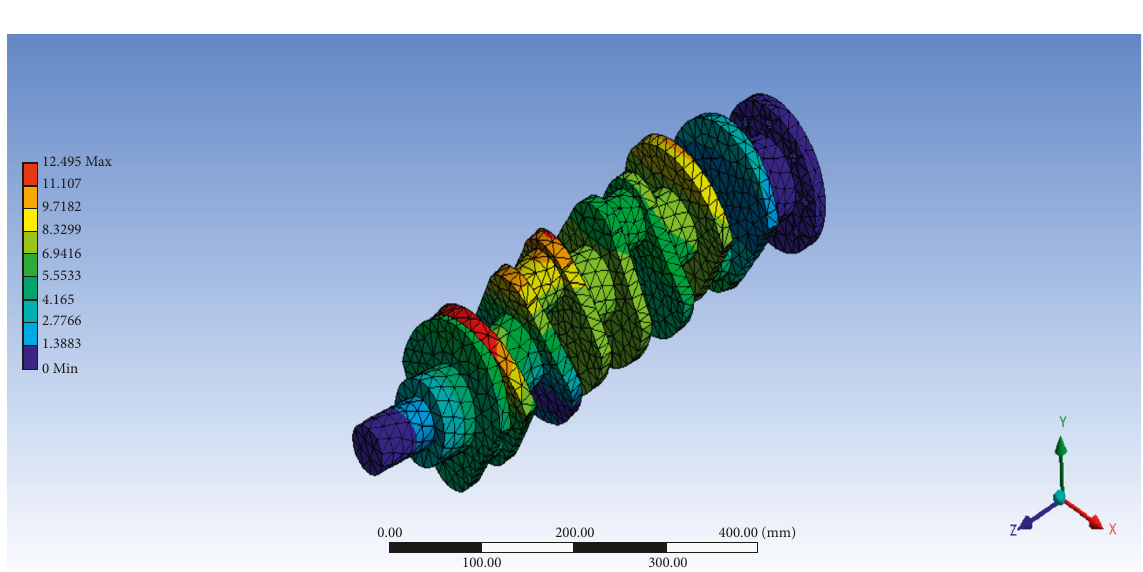
Figure 7: Deformation of stainless-steel crankshaft at the third mode of